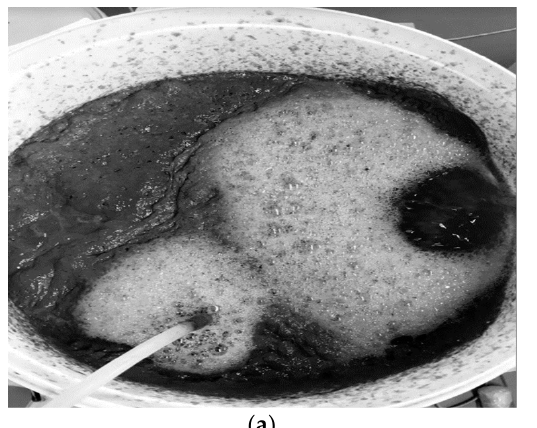
( b ) Figure 8. Boxplots of highlighted features before and after outliers’ replacement: ( a ) Boxplots before outliers’ replacement; ( b ) Boxplots after outliers’ replacement.